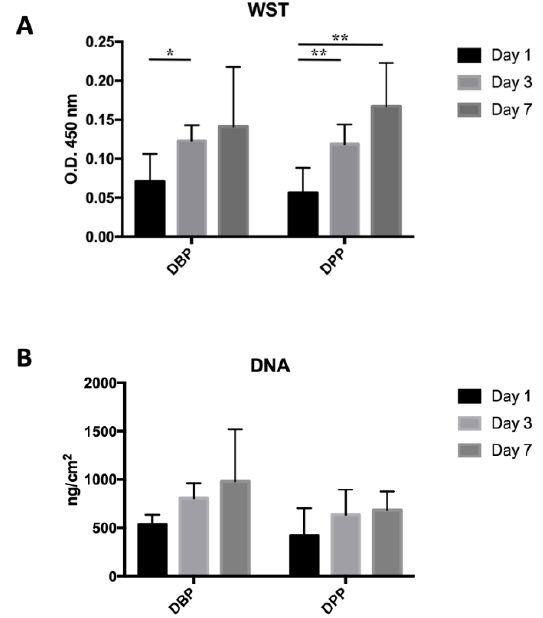
Figure 6. ( A ) Optical density (O.D.) values from the WST test on seeded tissues: a significant difference was present between days 1 and 3 for the bovine pericardium (* p < 0.05), while for the porcine pericardium, significant differences were present between days 1 and 3 and days 1 and 7 (** p < 0.01). ( B ) DNA extraction from decellularized tissues seeded with 20,000 cells/cm 2 : no significant difference was detected.